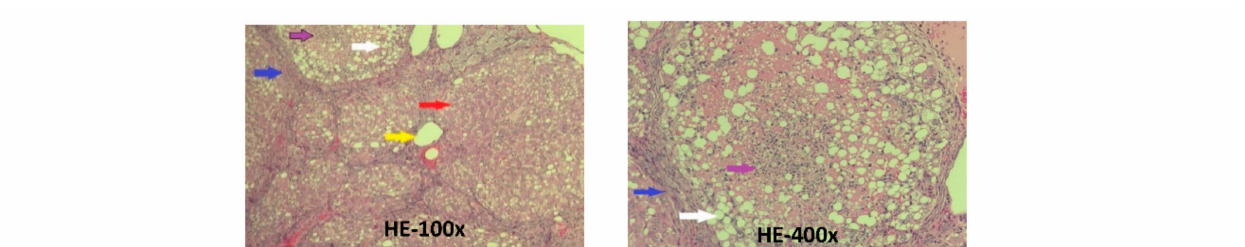
Figure 2. Photomicrographs of rat liver in control group stained with hematoxylin-eosin. The microscopic images of the liver in the CCl 4 group show that the standard structure of the liver was destroyed. The hepatic parenchyma was separated by the fibrosis septa from the center of the lobule to the portal areas and from the portal areas to the portal areas. Most lobules and the portal areas were invaded by bands of fibrosis; with the regeneration of hepatocytes, they formed pseudo lobules. The central vein of the central lobe was not clearly visible. Many fat degeneration cells, accompanied by infiltrated white blood cells surround the necrotic liver cells. These livers were stage F4 fibrosis [11] (Figure 3).